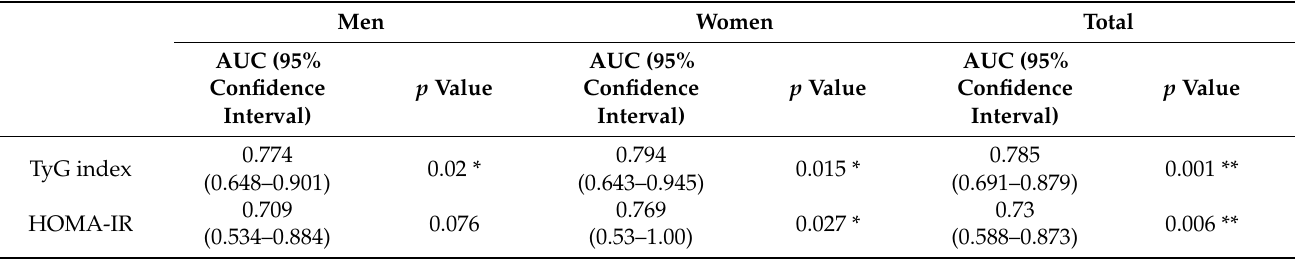
Table 5. Receiver operating characteristic (ROC) analysis for HOMA-IR and TyG index in the identification of insulin